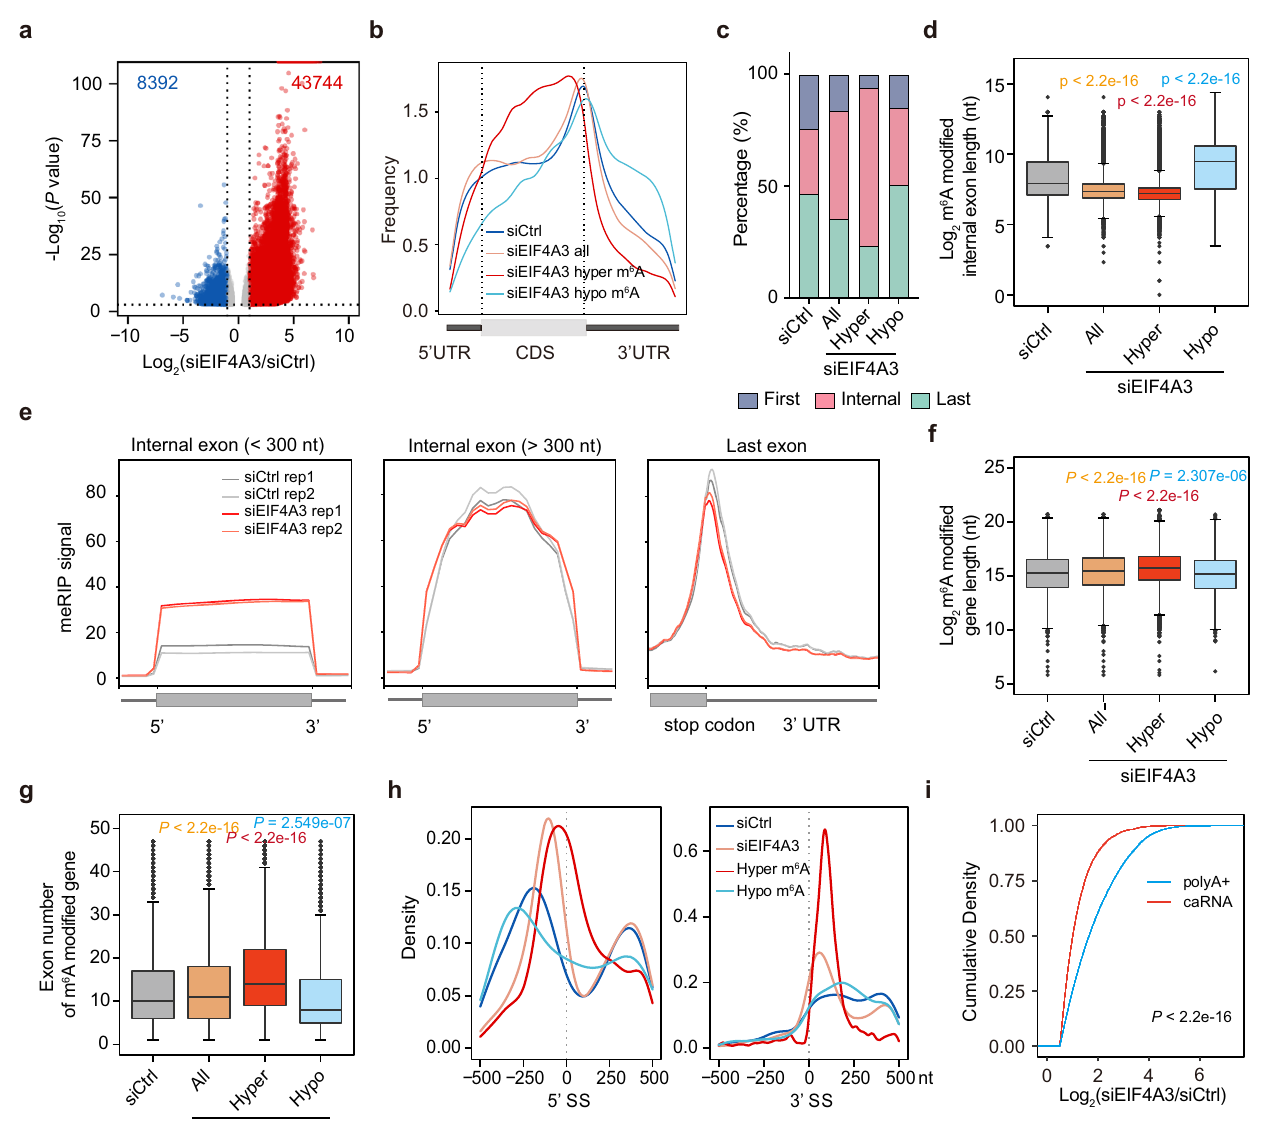
Fig.2|DepletionofEIF4A3increasesm 6 Amodi fi cationofshortinternalexons. a Differential m 6 A regions upon EIF4A3 depletion. Red dots represent increased m 6 A regions (hypermethylated m 6 A), Blue dots represent decreased m 6 A regions (hypomethylated m 6 A). b Metaplot showing the distribution of all m 6 A peaks in siCTRL and siEIF4A3, hypermethylated, hypomethylated m 6 A. c Barplot showing the percentage of different exons with m 6 A peaks in siCTRL and siEIF4A3, hyper- methylated, hypomethylated m 6 A. d The length of m 6 A modi fi ed internal exons in siCTRL and siEIF4A3, and the length of internal exons with hypermethylated or hypomethylated m 6 A. Solid line represents median, with whiskers indicating minimumtomaximumvalues. n =1743;6643;44,010;and1854.Statisticalanalyses, unpaired two-tailed Student ’ s t -test. e Aggregation plots showing m 6 A enrichment in short, long and last exon. Internal exons were divided into two groups based on